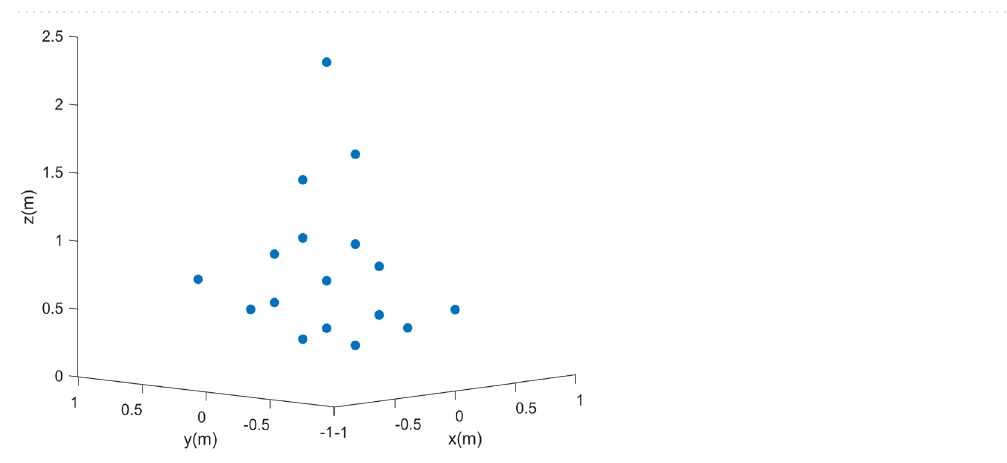
Figure 13. The 3D reconstructed imaging result of the point